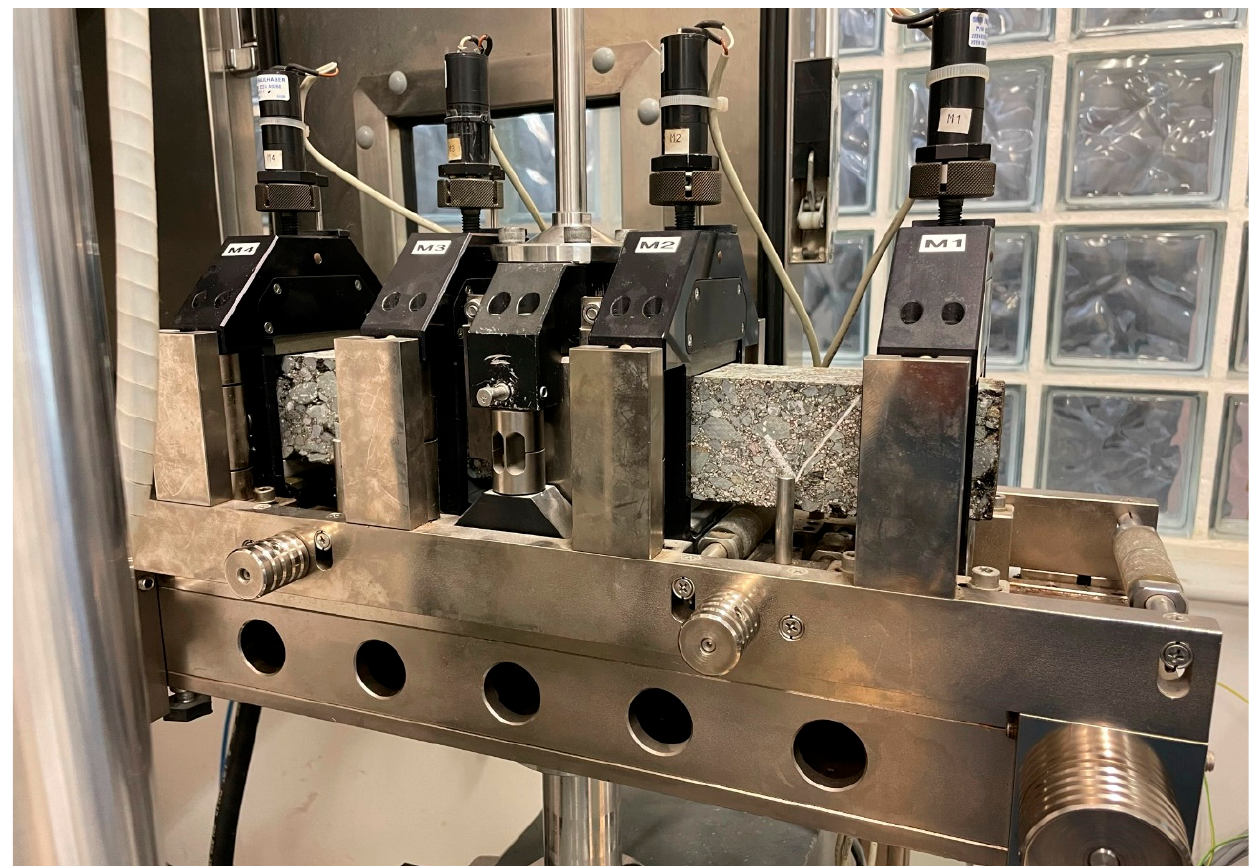
Figure 6. Fatigue resistance test.